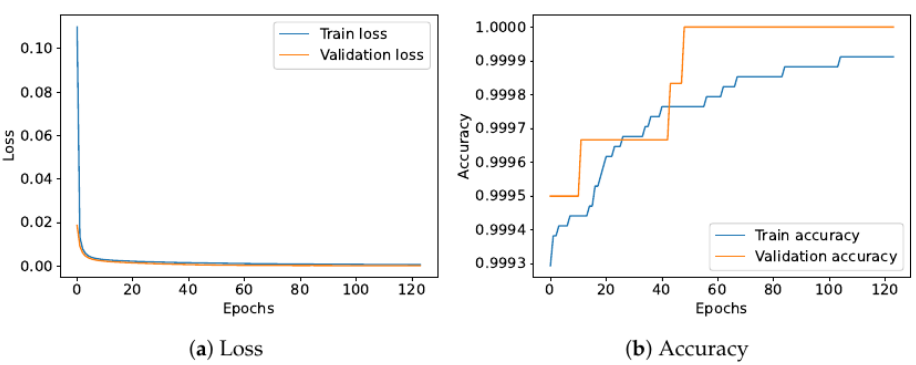
Figure 6. Validation curves extracted from the proposed model after the training process. In ( a ), we can observe that both the train and validation losses follow a decreasing trend as the number of training epochs increases. Both the curves converge at a very low value of the loss around zero, thus demonstrating that the model correctly learned the relationship between the input and the output with a very good level of generalization. Such a condition is also proven by ( b ), where, in this case, the training and validation accuracy increase with the training epochs, reaching very high values around one.